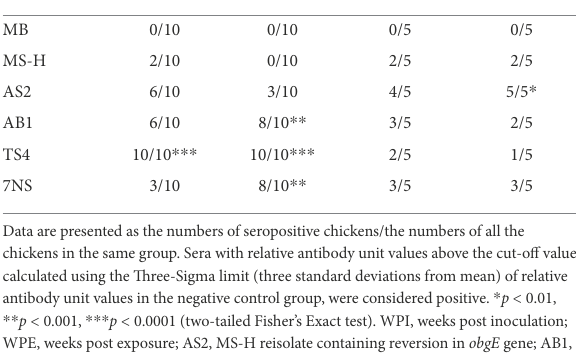
TABLE 4 Reisolation of the M. synoviae strains from upper trachea (UT), lower trachea (LT), or air sacs (AS), 2- and 3-week after aerosol inoculation of SPF chickens with various strains or reisolates of M. synoviae following intratracheal inoculation with a virulent strain of IBV, and 2- and 3-week after exposure of in-contact chickens with the inoculated chickens.